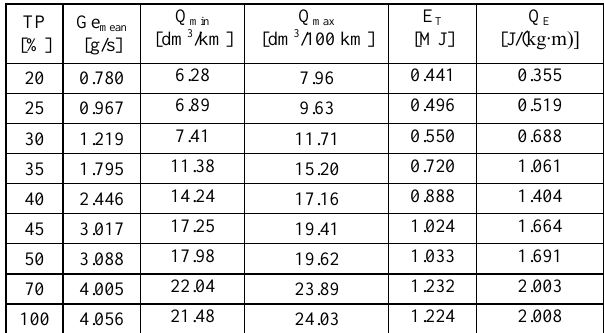
Table 2. List of energy parameters for the acceleration process in ¼ mile